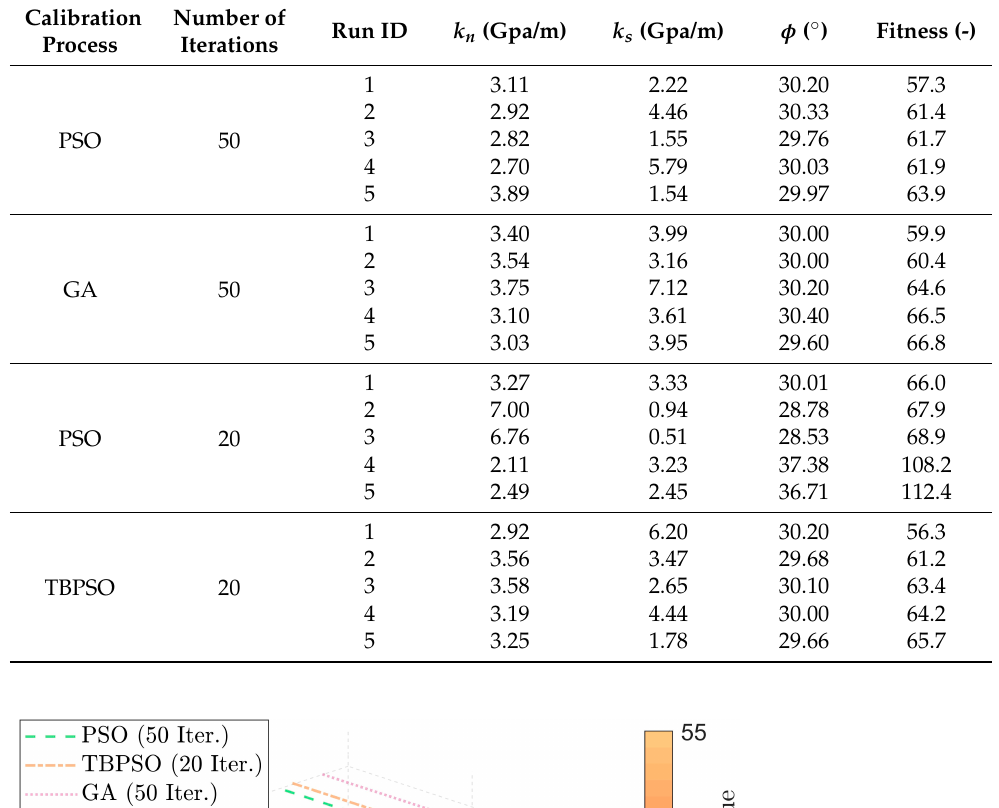
Table 3. Five best solution sets for objective function 1 of densely meshed geometry.